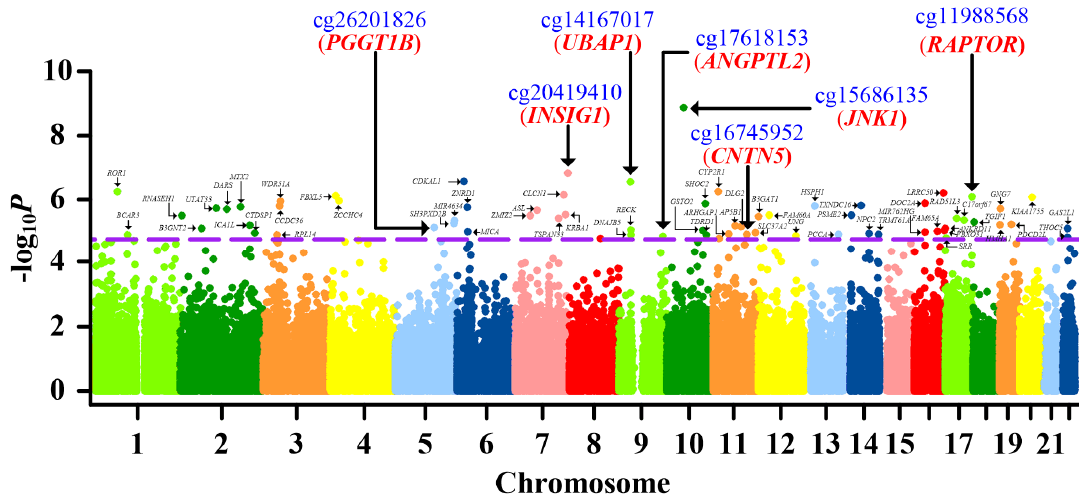
Figure 1. Manhattan plot of the promoter-wide methylation association in gout. X-axis shows chromosomal positions. Y-axis shows minus log 10 P of differential methylation tests for probed CpG sites. The dashed line indicates the false discovery rate significance threshold of 0.05. The 66 CpG sites passing multiple corrections are labeled with corresponding gene names. CpGs retained in the final analysis (cg26201826, cg20419410, cg17618153, cg15686135, cg14167017, cg11988568, and cg16745952) and corresponding genes ( PGGT1B , INSIG1 , ANGPTL2 , JNK1 , UBAP1 , RAPTOR , and CNTN5 ) are highlighted with blue and red, respectively. The associations between CpG methylation and gout are calculated with multiple regression, correcting for sex, age, smoking history (total pack-years), smoking status, alcohol consumption, and blood cell subsets.